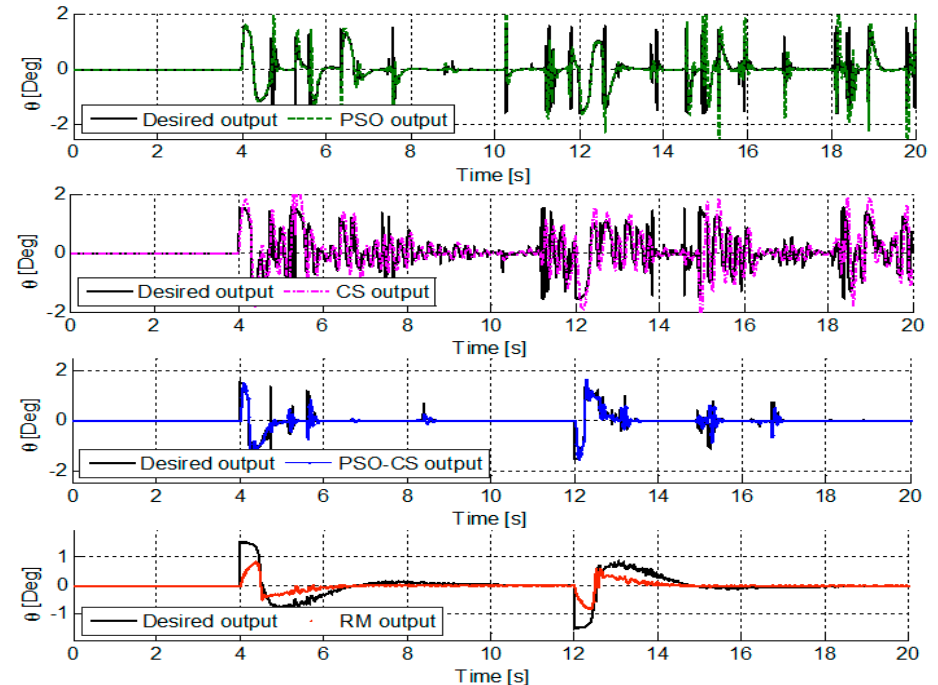
Figure 14. Quadrotor’s pitch attitude ( θ ) using Particle Swarm Optimization (PSO), Cuckoo Search (CS), Particle Swarm Optimization-Cuckoo Search (PSO-CS), and Reference Model (RM) with disturbance (rectangular trajectory).